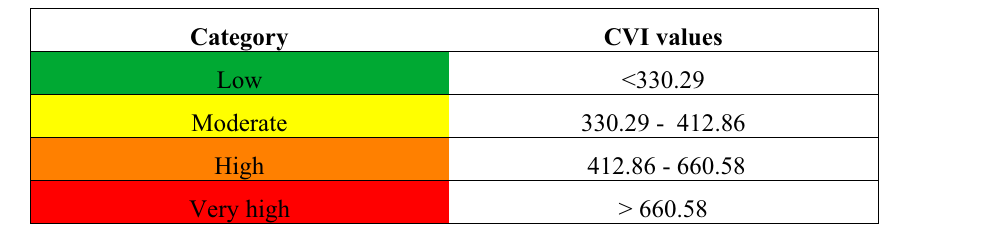
Table 6. Vulnerability